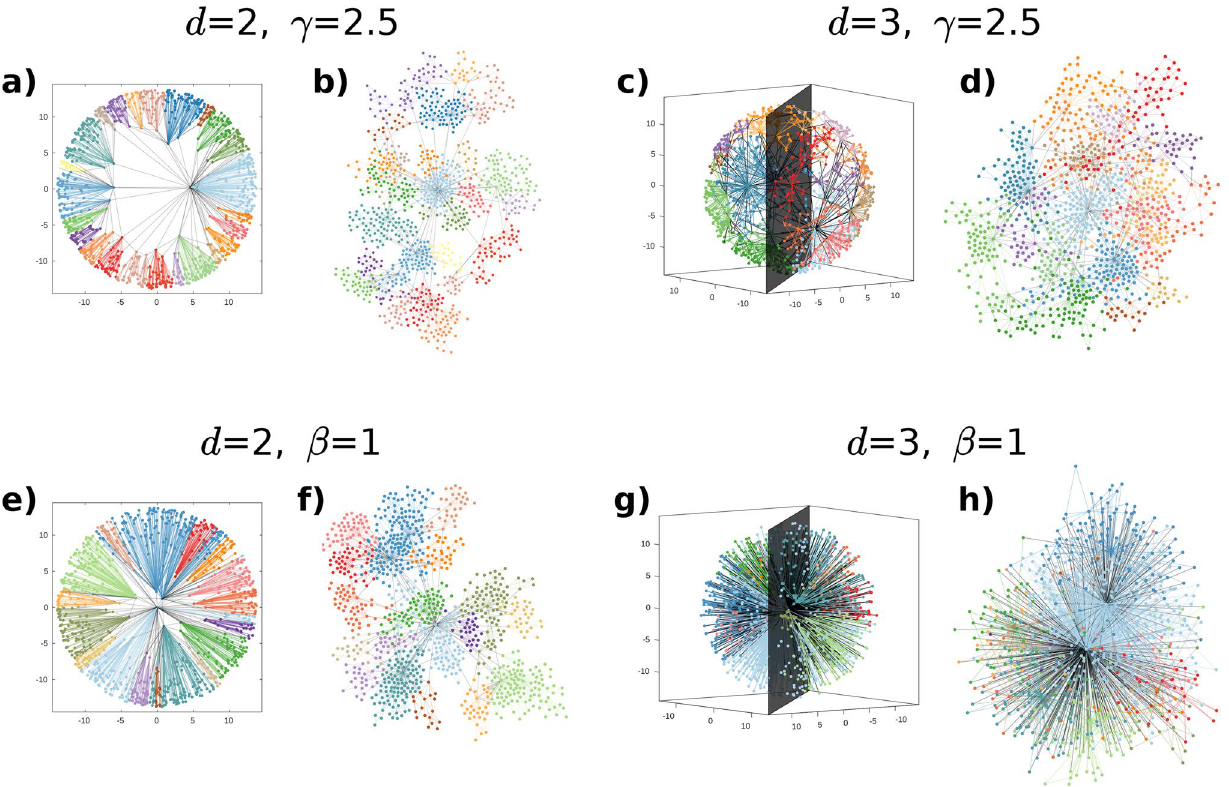
Figure 1. Layouts of networks generated by the d PSO model in 2- and 3-dimensional hyperbolic spaces of 1 . The colouring of the nodes and the links indicates communities found by the Louvain curvature K = − algorithm. In panels a , c , e , g we display the network in the native d -dimensional hyperbolic ball, whereas panels b , d , f , h show the standard Euclidean layout of the same graph for comparison. In the top row, we present 2.5 , generated on the 2-dimensional hyperbolic plane, setting networks of the same degree decay exponent γ = the popularity fading parameter β to 2/3 (panels a , b ), and in the 3-dimensional hyperbolic space, setting the popularity fading parameter β to 1/3 (panels c , d ). In the bottom row, we show networks of the same popularity 1 , corresponding to the smallest degree decay exponent achievable in a given dimension, fading parameter β = 2.0 in the 2-dimensional case (panels e , f ) and γ 1.5 in the 3-dimensional case (panels g , h ). For namely γ = = each network, we set the number of nodes N to 1000, the expected average degree 2 m to 4 and the temperature c of the displayed networks and the modularity Q for their displayed T to 0. The average clustering coefficient ¯ c c 0.882 for panels a , b ; 0.845 for panels c , d ; 0.729 and Q 0.644 and Q partitions are the following: = = ¯ = ¯ = c c 0.829 for panels e , f ; while 0.354 for panels g , h 0.788 and Q 0.964 and Q = = ¯ = ¯ =